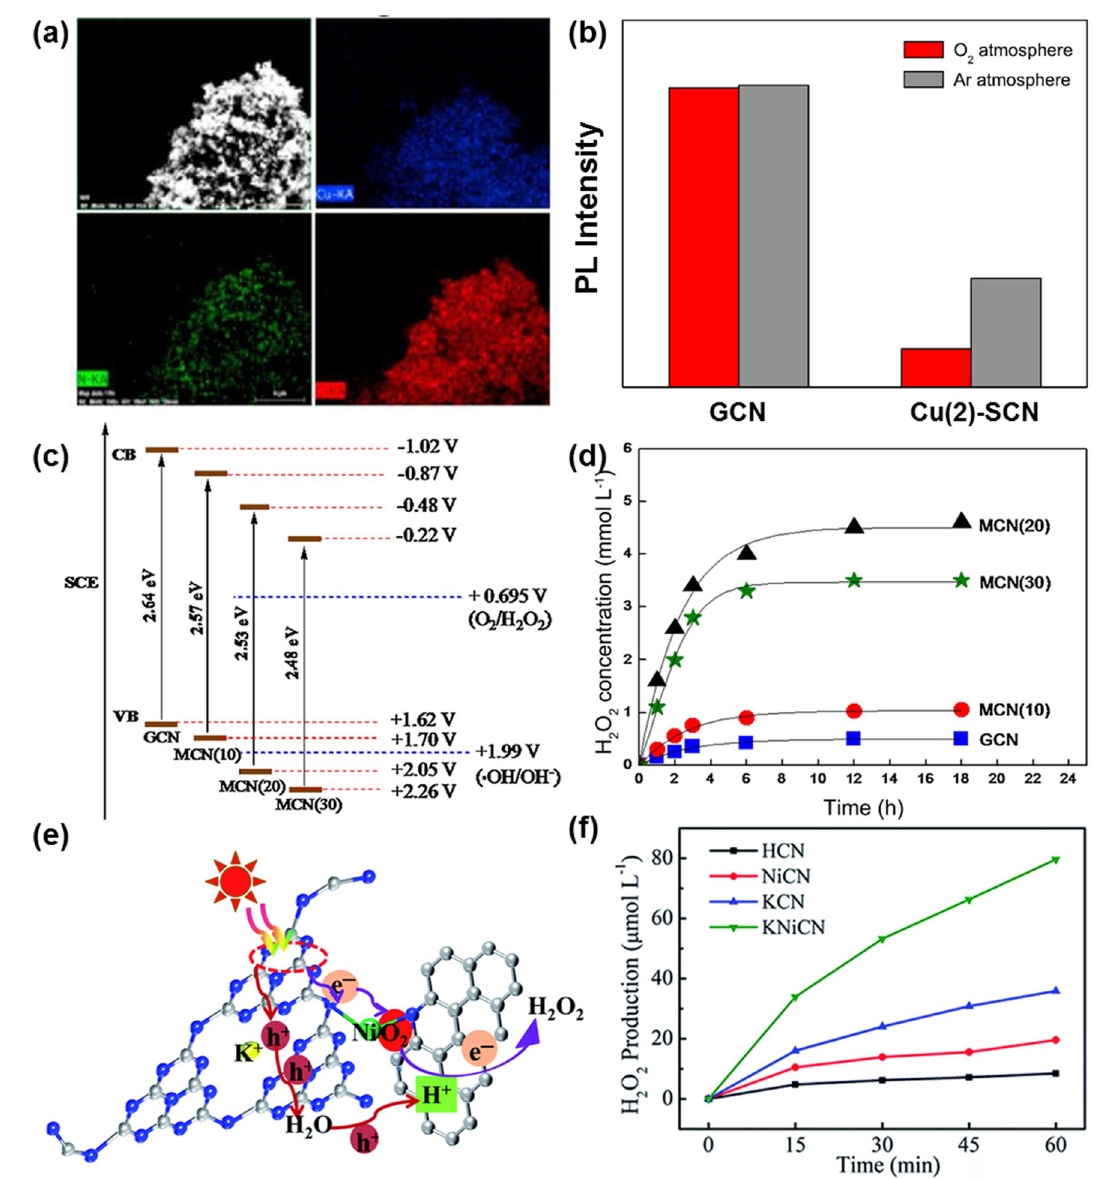
Fig. 6 a Elemental mapping images of Cu(2)-SCN. b PL intensities of GCN and Cu(2)-SCN. Reproduced with permission from Ref. [109]. Copyright 2017 Elsevier. c Band gap structures of various catalysts. d H 2 O 2 concentration over catalysts under visible light. Reproduced with permission from Ref. [110]. Copyright 2018 Elsevier. e Proposed mechanism of H 2 O 2 production over the KNiCN catalyst. f Photocatalytic H 2 O 2 production on the catalysts in pure water. Reproduced with permission from Ref. [111]. Copyright 2021 Royal Society of